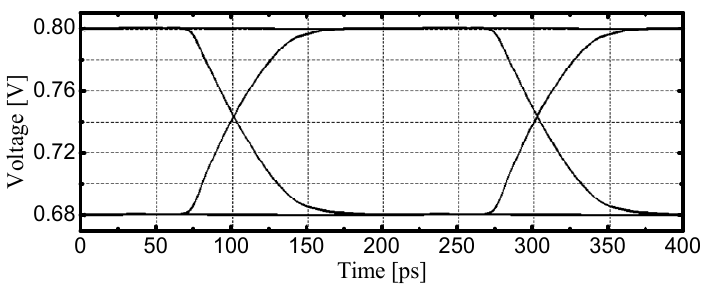
Figure 12. Eye-diagrams for a 5 Gbps, 60,000 bits PRBS.